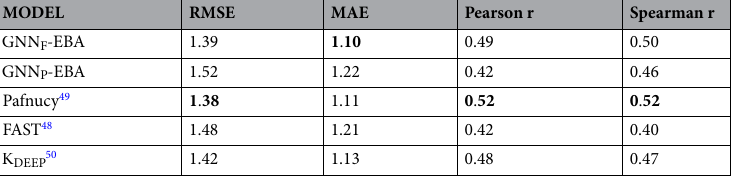
Table 8. Performance comparison of our GNN models in predicting experimental affinity on the PDBbind2019 structure-based evaluation dataset. The results for the FAST method are reported for its 3D CNN model. The top scores are shown in bold.